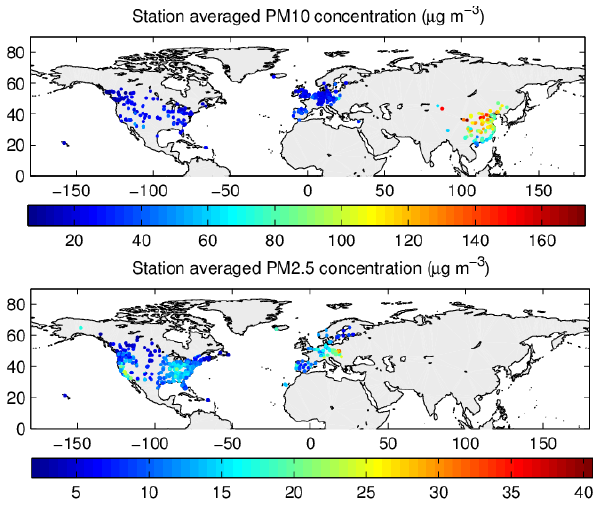
Figure 2. A map of station multi-year averaged PM10 and PM2.5 mass Fig. 2. A map of station multi-year averaged PM 10 and PM 2 . 5 mass concentration (unit: μ g m -3 ). concentration (unit: µgm − 3 ) .